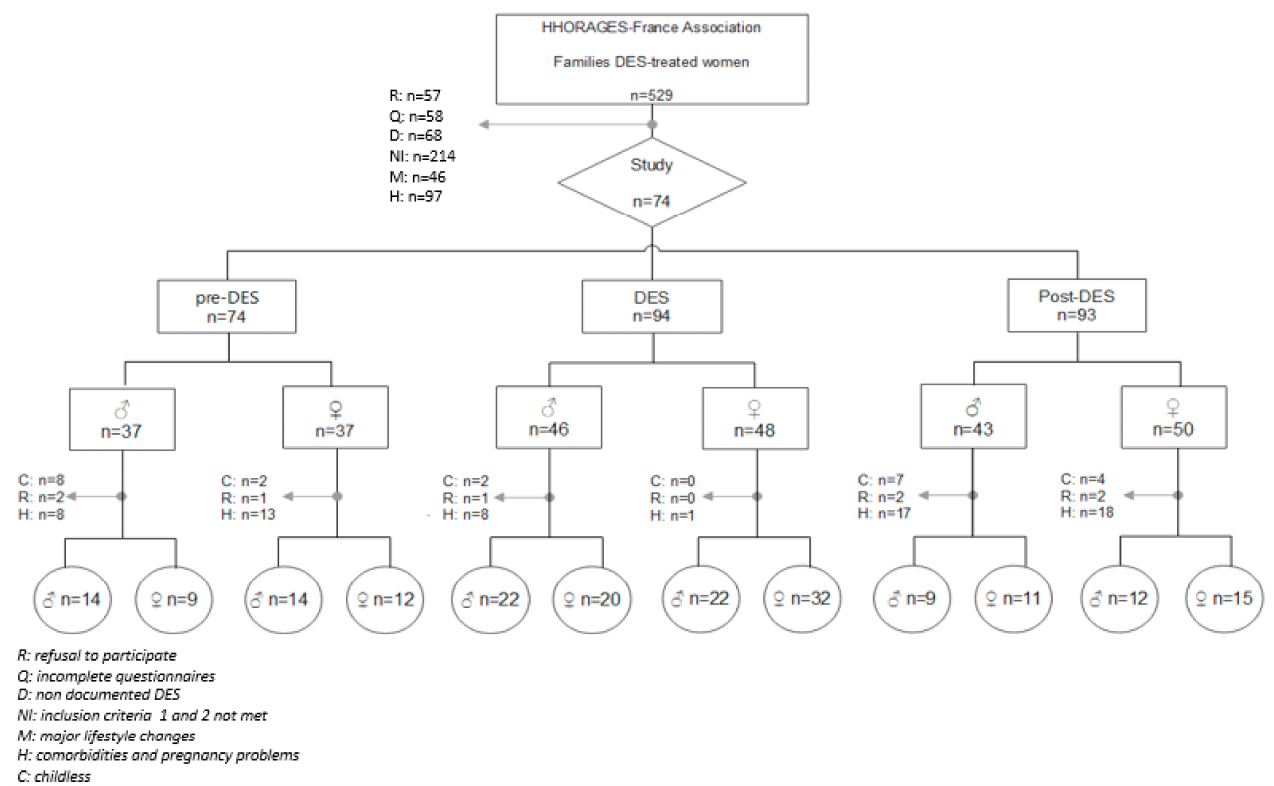
Figure 1. Flowchart of the families included in the study. More than one answer was possible. Table 1. Characteristics of the excluded families.